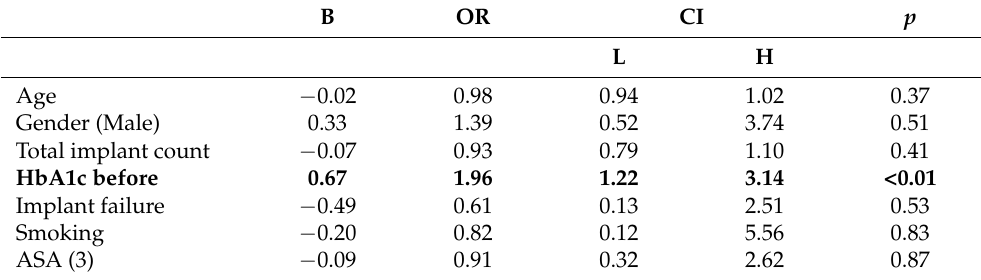
Table 3. Multivariate analysis (individual